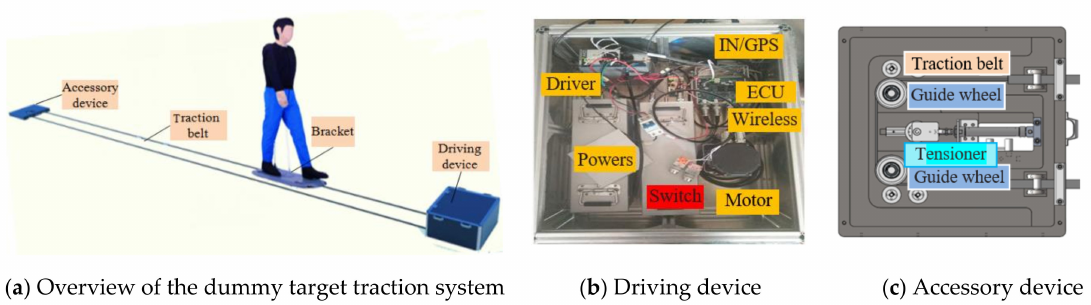
Figure 4. Dummy target traction